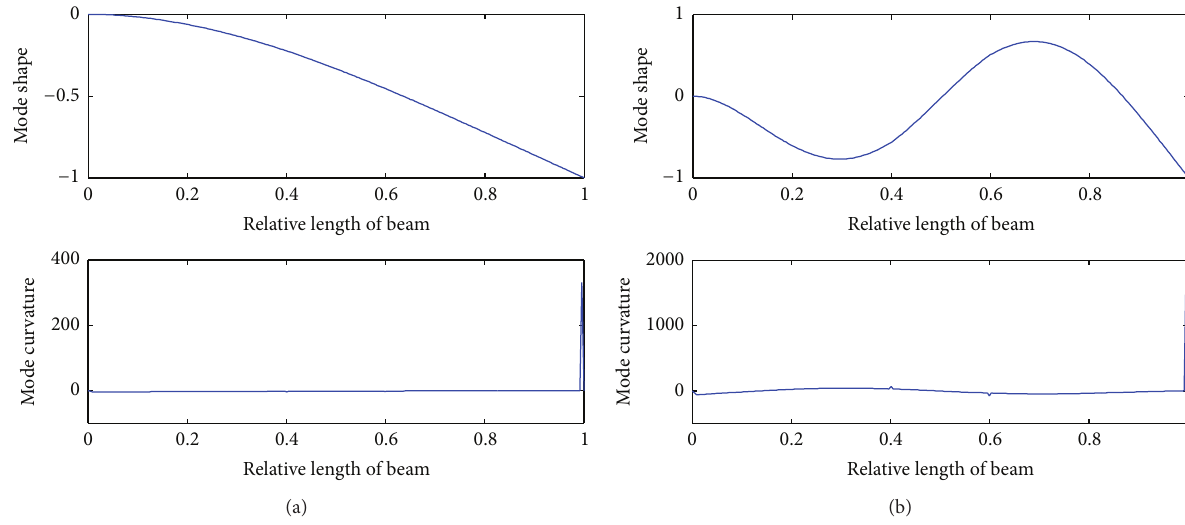
Figure 2: Crack location identification results using mode curvature-based method. (a) The first mode shape. (b) The third mode shape.